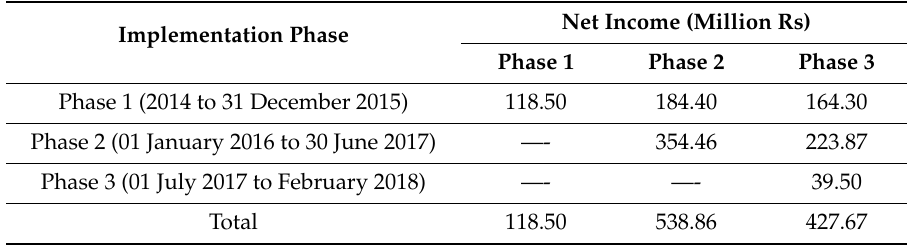
Table 5. Net household income derived from the implementation of the BTAP in the Shangla, Swat, and Lower Dir districts (Phases